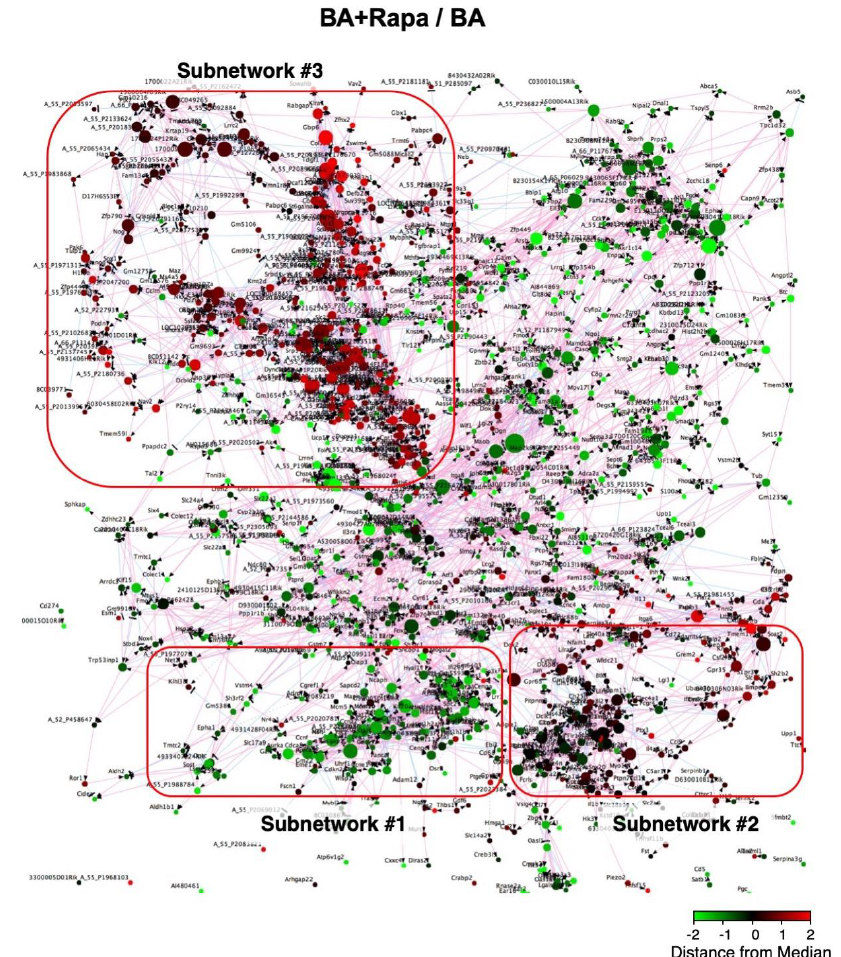
Figure 3. Gene expression network in AD. Organic plot of the Bayesian network analysis for gene expression. Each node represents a single gene that is color coded for induction (red) or suppression (green) by rapamycin in the presence of BAPN + AngII challenge. The genes are connected by red or blue edges that represent positive or negative correlations, respectively, between a pair of genes on both sides of the edge. The higher the correlations are, the closer the genes are plotted. Three clusters of the nodes represent the groups of genes making tightly coupled subnetworks (#1, #2, and #3) for their expressions.